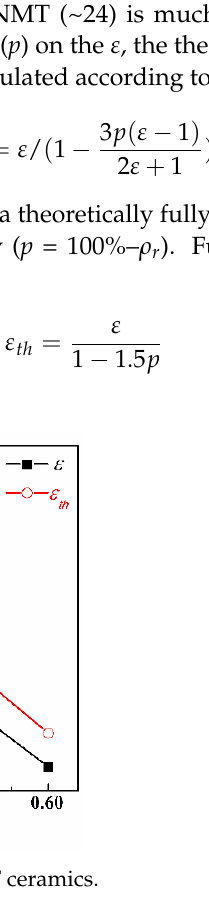
Figure 7. The Qf value of the (1– x )CLT- x NMT ceramics. Similarly, the effect of porosity ( p ) on the Qf value (with 10 3 ~10 4 GHz order of mag- nitude) can be evaluated by the following equation [18]: 0 (1 1.5 ) =